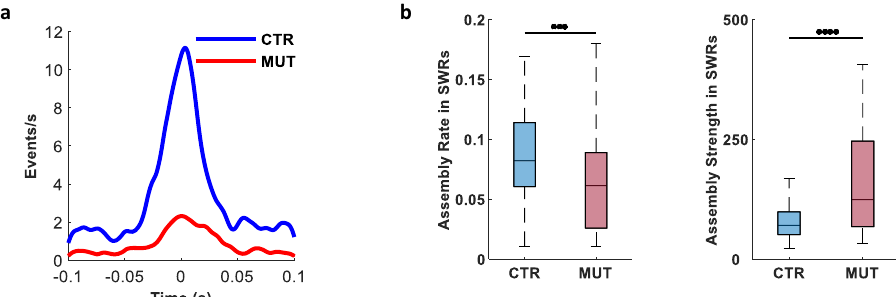
Fig. 3 CA3 input is required for bilateral coordination of SWRs and assembly reactivation in CA1. a Cross-correlation of SWRs across hemispheres demonstrates a loss of temporal coordination in CA3-TeTX mice (CTR, N = 4 mice, n = 4 pairs of tetrodes; MUT, N = 5 mice, n = 5 pairs of tetrodes; P = 5.24 × 10 − 30 ). b Assembly reactivation rate during SWRs was signi fi cantly reduced in mutants (CTR, N = 4 mice, n = 115 assemblies; MUT, N = 5 mice, n = 118 assemblies; P = 1.27 × 10 − 7 ); however, strength was signi fi cantly increased ( P = 2.81 × 10 − 4 ). All signi fi cant difference in Fig. 3 were tested with two-sided Wilcoxon ’ s rank-sum test.